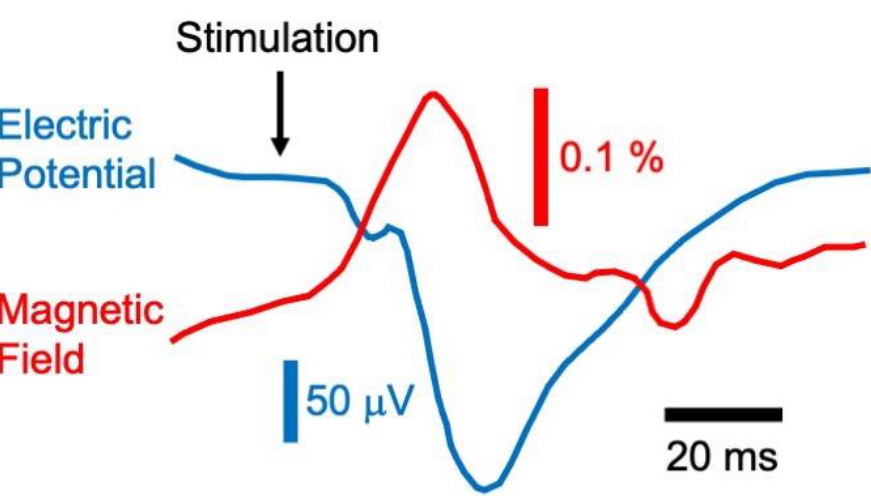
Figure 13. The magnetic field and the electrical potential measured by Toi et al. The electric and magnetic signals had similar latencies, about 25 ms, and thus may both be associated with the same neural source and are far too fast to be explained by the blood-oxygen-level-dependent mechanism of fMRI. Adapted from Figure 1I in [79].